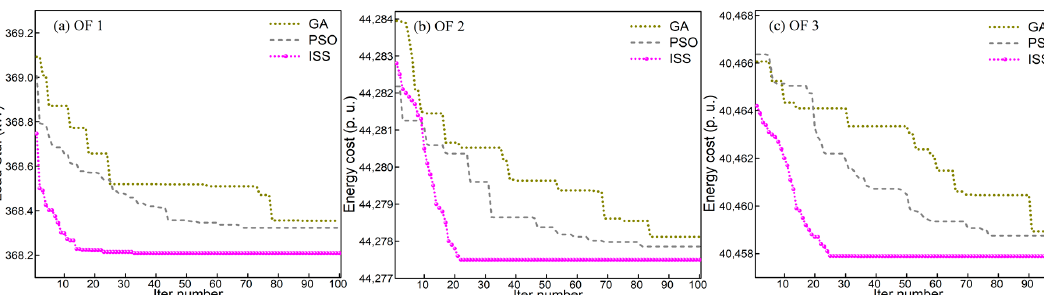
Figure 8. Iteration map for single EV with different objectives under CD-C mode. ( Left ) Load standard deviation with OF1; ( Center ) Energy cost with OF2; ( Right ) Energy cost with OF3. (2) Group EV charging For massive amounts of EVs connecting to a charging station or regulated by an aggregator, the proposed GA-ISS hybrid method can help smooth the load profile or minimize the overall charging